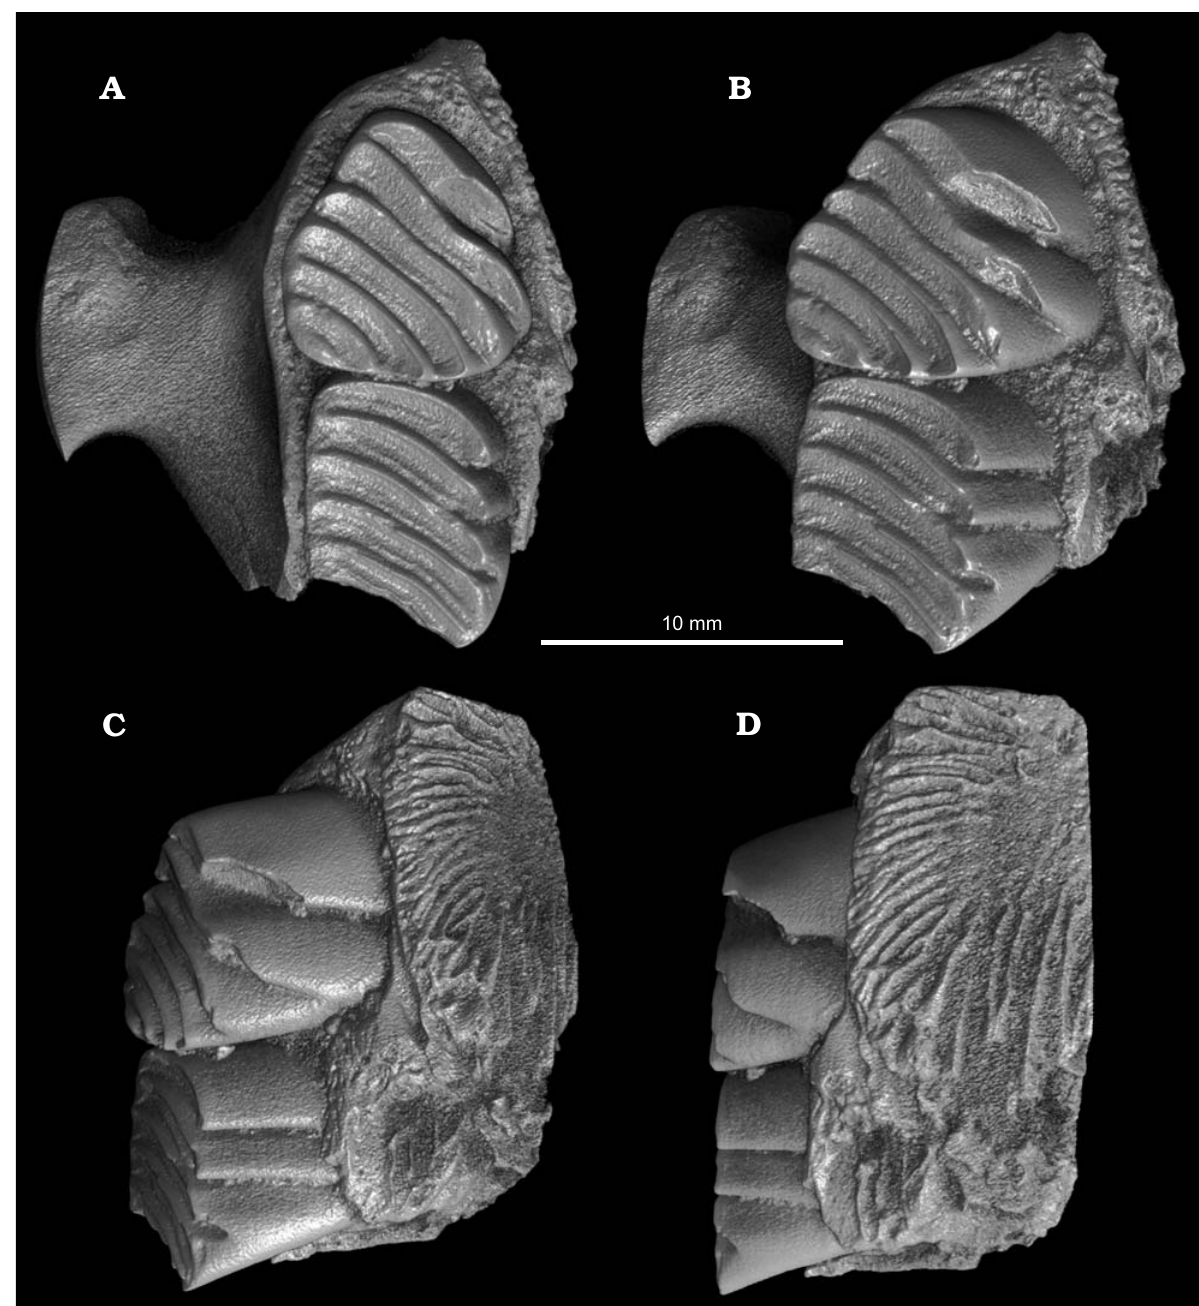
Fig. 5. Sequence of tridimentional reconstructions of the maxilla of potamarchine rodent Pseudopotamarchus villanuevai gen. et sp. nov. (UFAC 4762) from Solimões Formation, Late Miocene, Brazil; from occlusal to medial view ( A – D